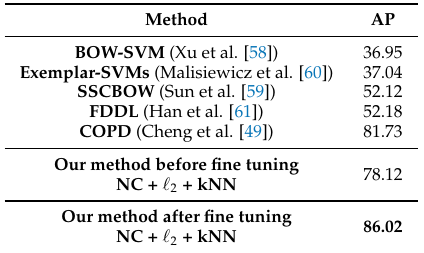
Table 7. Results for ship classification using the MWPU VHR-10 dataset. The Xception network weights obtained from MASATI were used directly (without fine tuning), and the network was also fine-tuned with the MWPU data for 20 epochs and without data